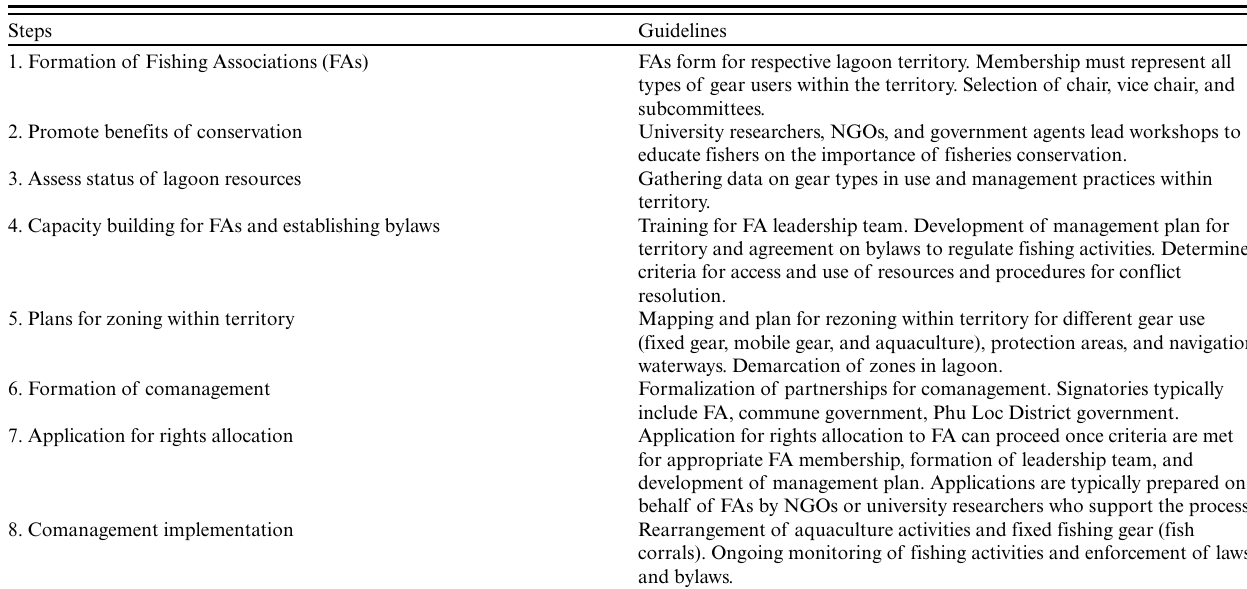
Table 1 . Steps and guidelines for the establishment of comanagement and allocation of collective property rights in the Cau Hai Lagoon.